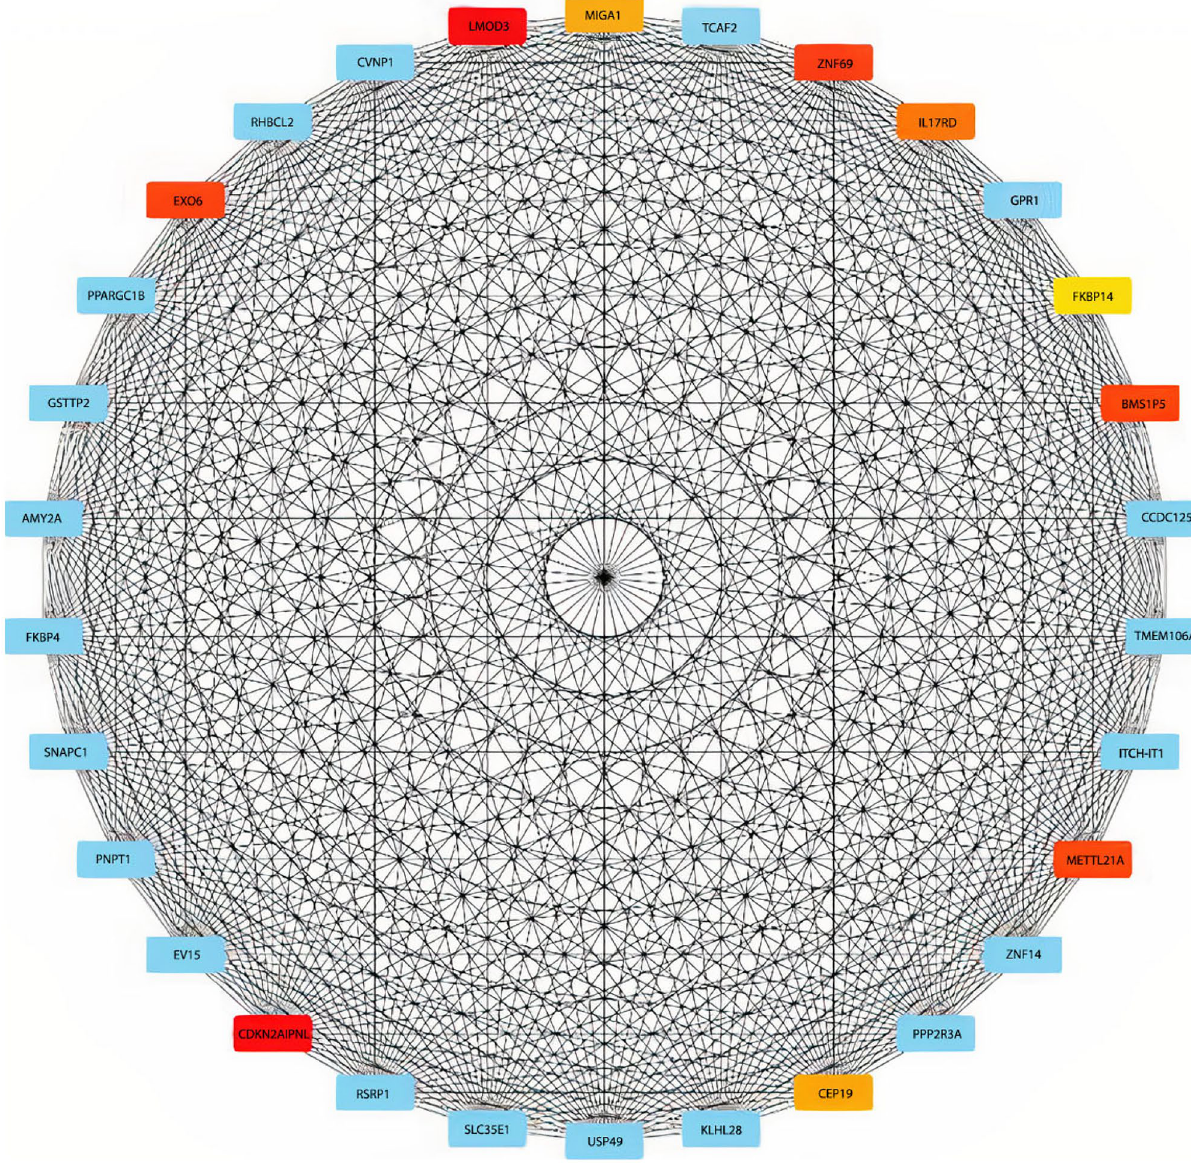
Figure 4. Black module network. The network of the top 30 genes or the most influential black module genes that are most closely related show the highest to lowest scores among these 30 genes in red, orange, yellow, and blue,